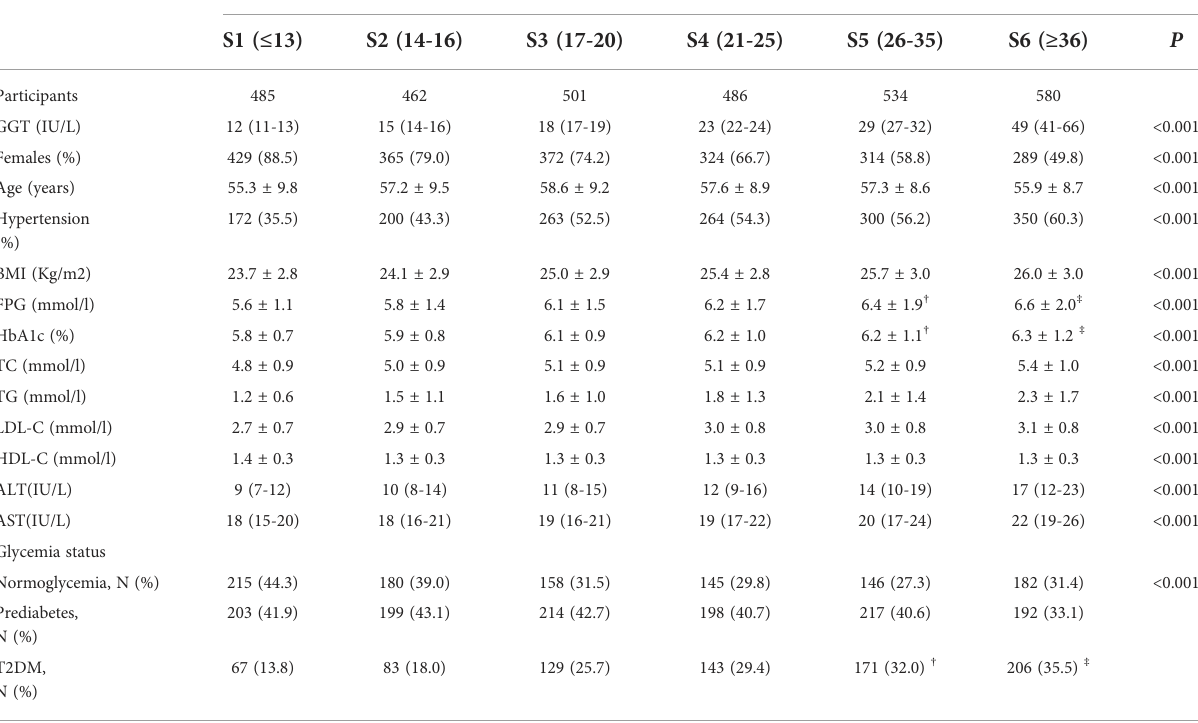
TABLE 2 Clinical and demographic characteristics of the study population strati fi ed by the sixtiles of GGT levels.